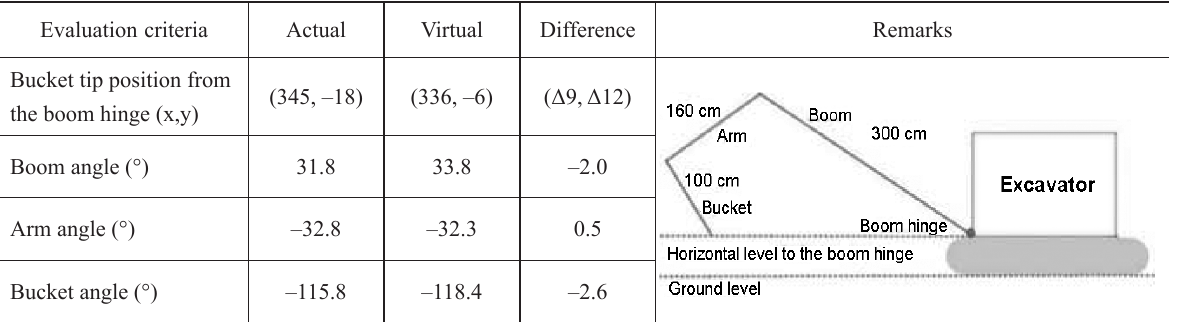
Table 2. Comparison of actual and measured angles Evaluation criteria Actual Virtual Difference